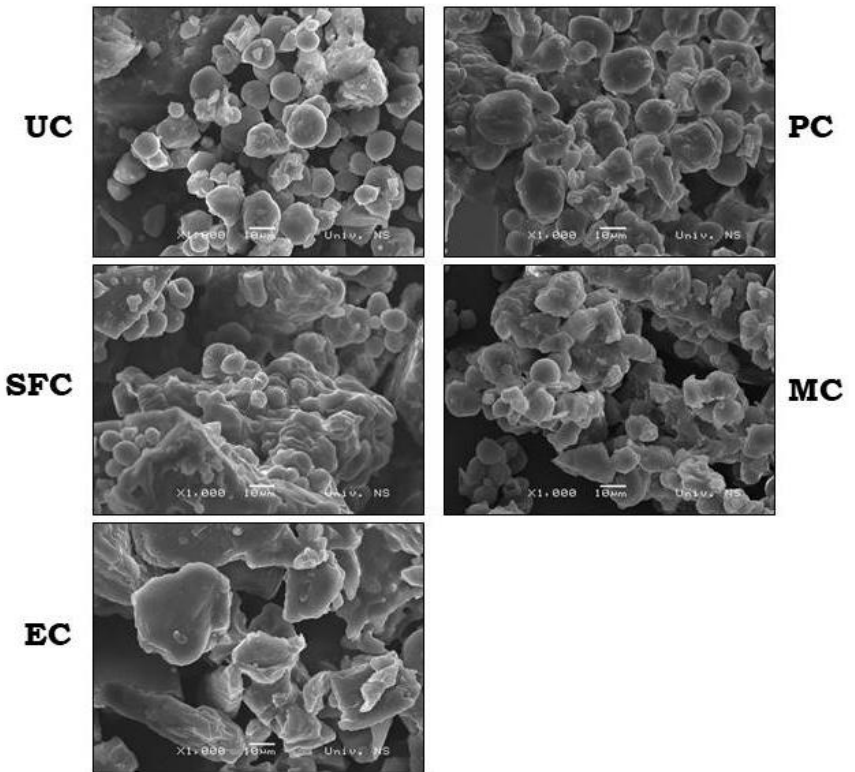
Figure 3. Scanning electron microscopy images of unprocessed and heat-treated corn samples (UC—unprocessed corn; PC—pelleted corn; SFC—steam-flaked corn; MC—micronized corn; EC— (UC-unprocessed corn; PC-pelleted corn; SFC-steam-flaked corn; MC-micronized corn; EC-extruded corn). extruded